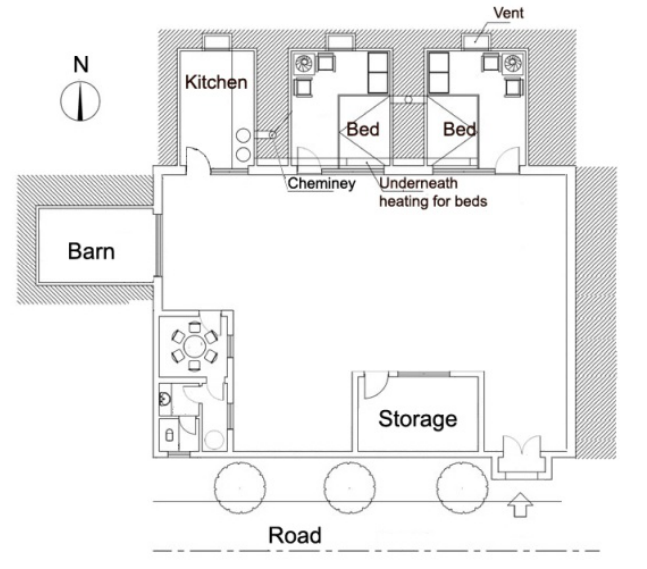
Figure 11. Cave-dwelling